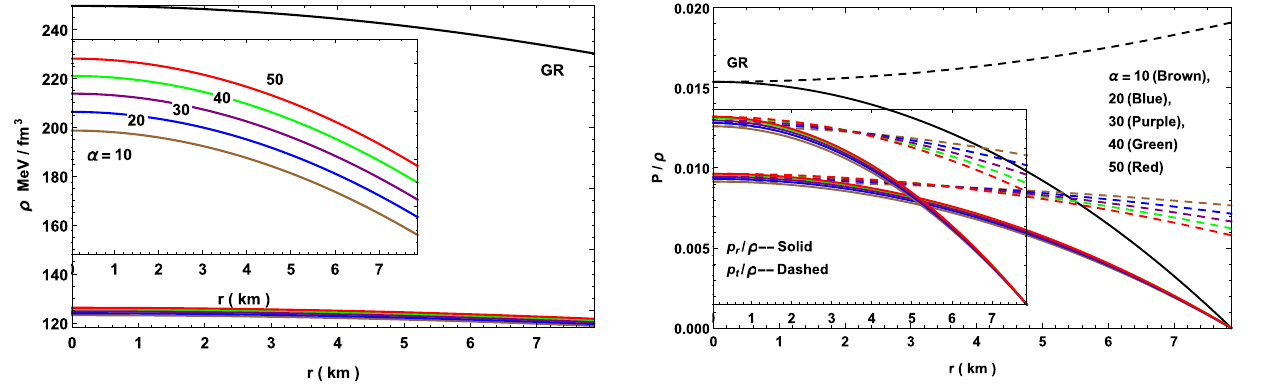
Fig. 5 Variation of the equation of state parameters for 4U 1538-52 using the parameter provided in Table 1